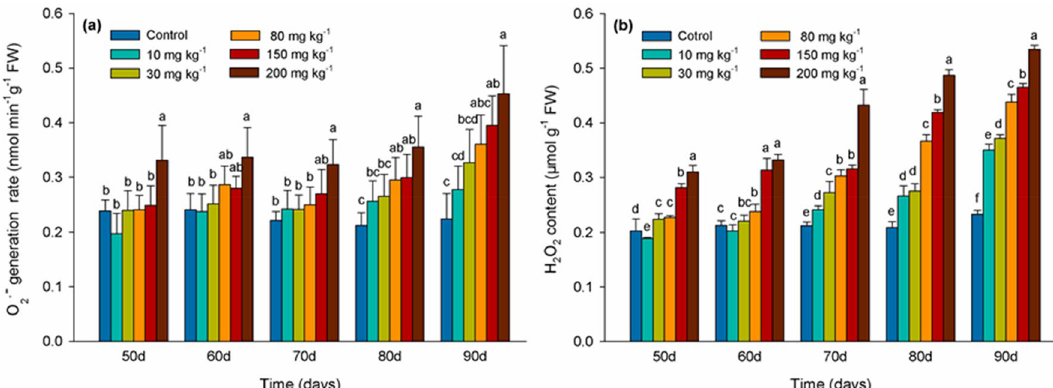
Figure 1. Rate of superoxide radical (O 2·− ) generation ( a ) and hydrogen peroxide (H 2 O 2 ) levels ( b ) in leaves of Lonicera japonica Thunb. cuttings exposed to different concentrations of Cd. Different letters indicate a significant difference ( P < 0.05) based on Duncan’s multiple range test at 5% level. Values are the mean ± SD (n = 3).